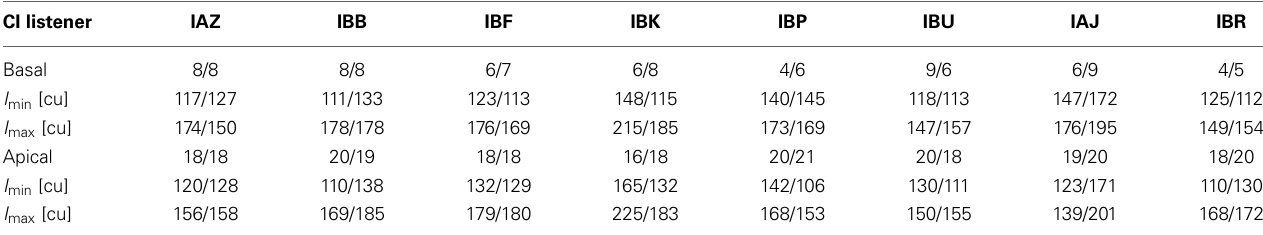
Table 2 | The left and right (L/R) electrodes in each pair, the threshold level I min in clinical units (cu), and the most comfortable level I max , for 0% modulation depth at